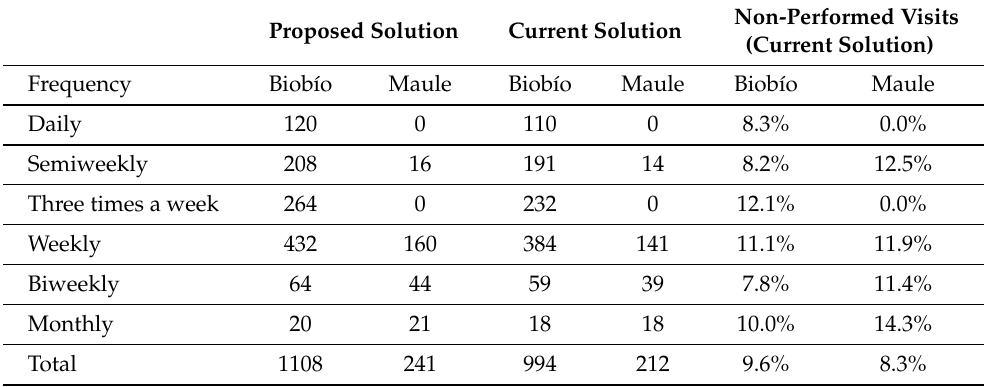
Table 8. Model Results versus Current